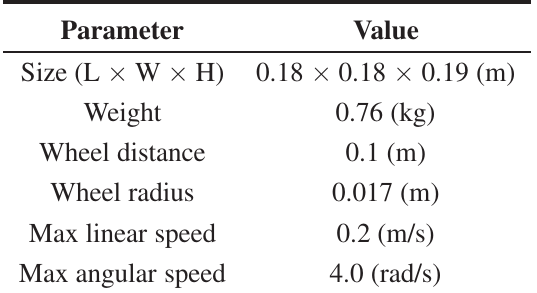
Table 1. Physical characteristics of vehicles.